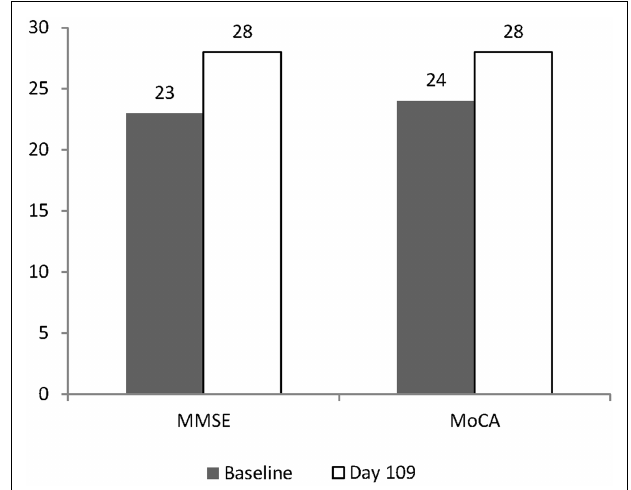
FIGURE 2 | Change in MMSE and MoCA after 109days . Baseline values are shown as shaded columns. Day 109 values are shown as open columns. Baseline values were obtained on August 31st, 2012.The day after the Baseline evaluation, the patient started on CT using a graduated dosing schedule for 7days, and for the remaining 102days was dosed at 40g (20g of CT). Day 109 values were obtained on December 18th,